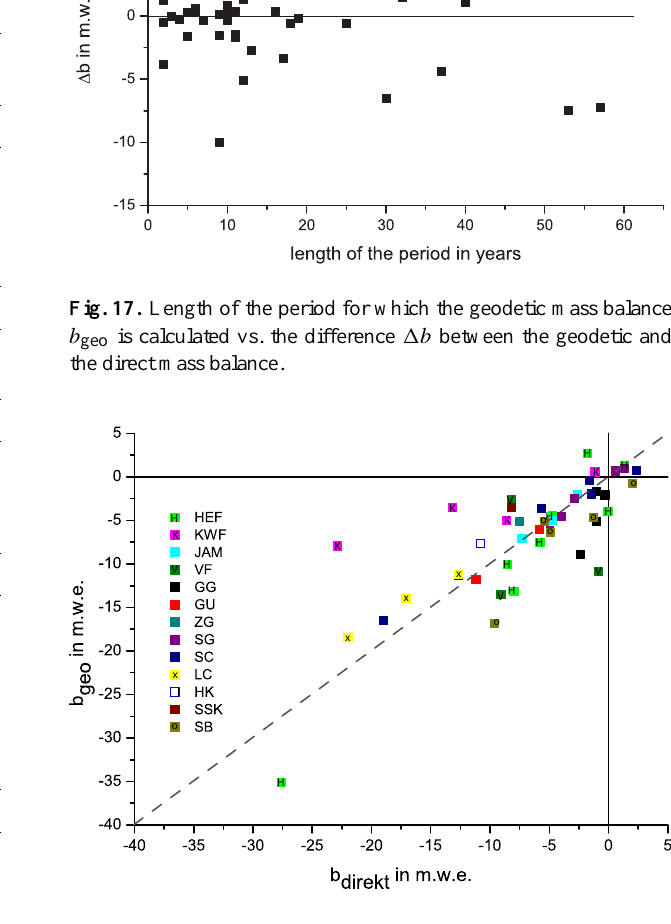
Table 4. Results of the cumulative specific mass balance for the geodetic b geo and the direct b direct method. The difference between the geodetic and the direct method is given in absolute numbers and divided by the number of years N . The numbers are rounded, the difference is calculated from the full values. ∗ – calculation from volume change assuming a density of 850kgm − 3 .